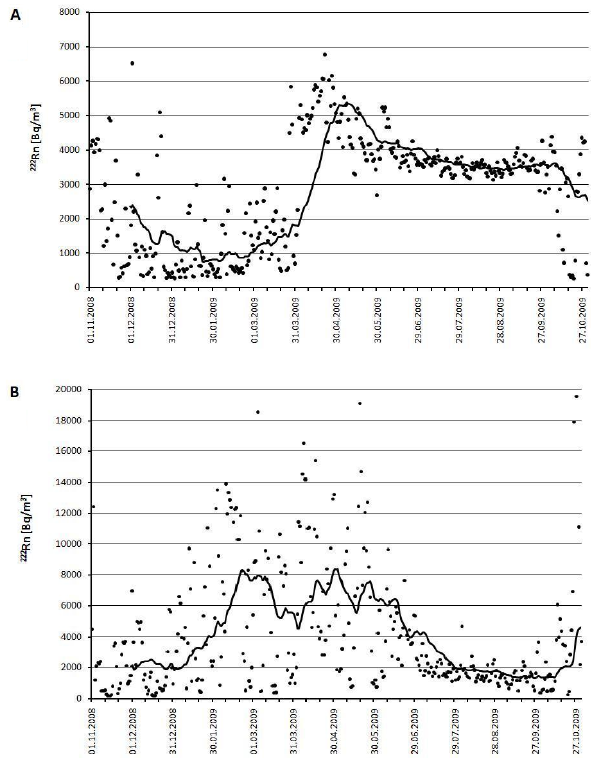
Fig. 4. Fig. 4. Changes in 222 Rn activity concentration during the year- long monitoring measurements in Bear Cave in Kletno (A) and Flu- orite Adit in Kletno (B) . Points represent mean daily values of radon concentration, and the line – the moving average with period of 30